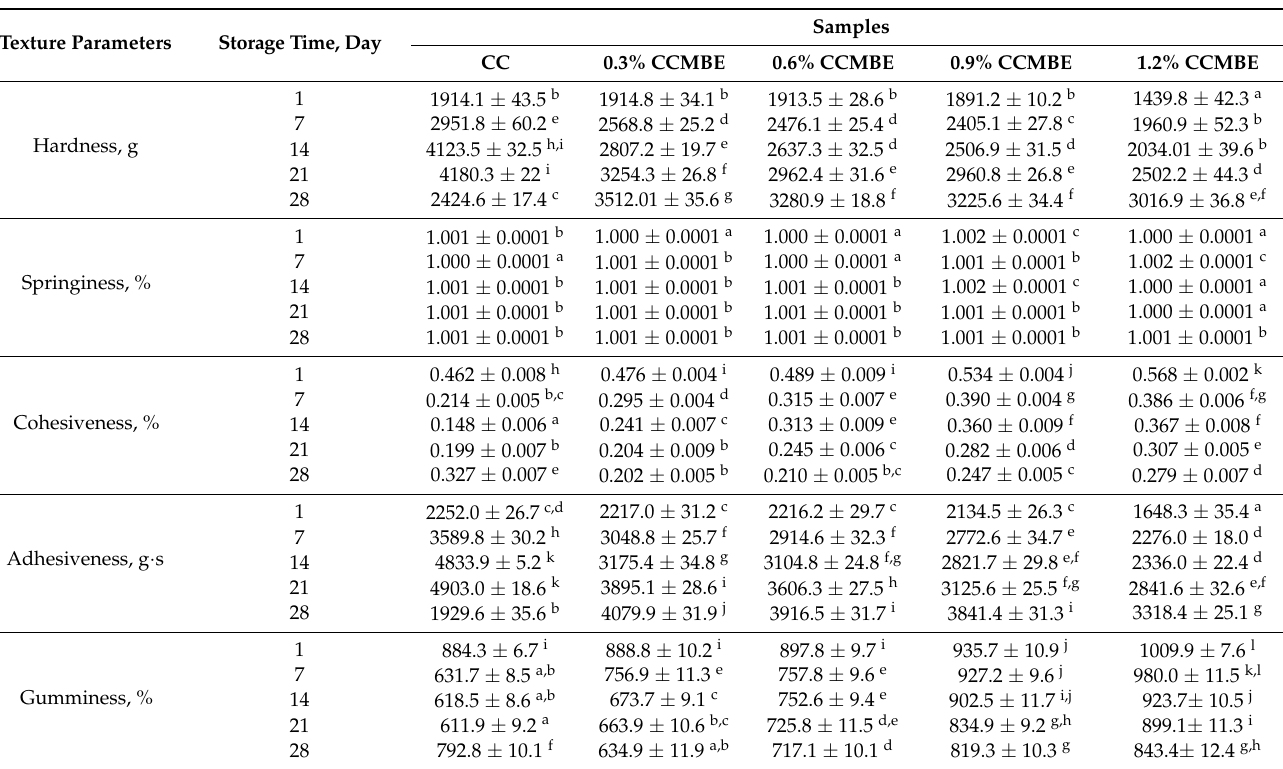
Table 6. Texture parameters’ evolution of cream cheese fortified with microencapsulated basil extract, during